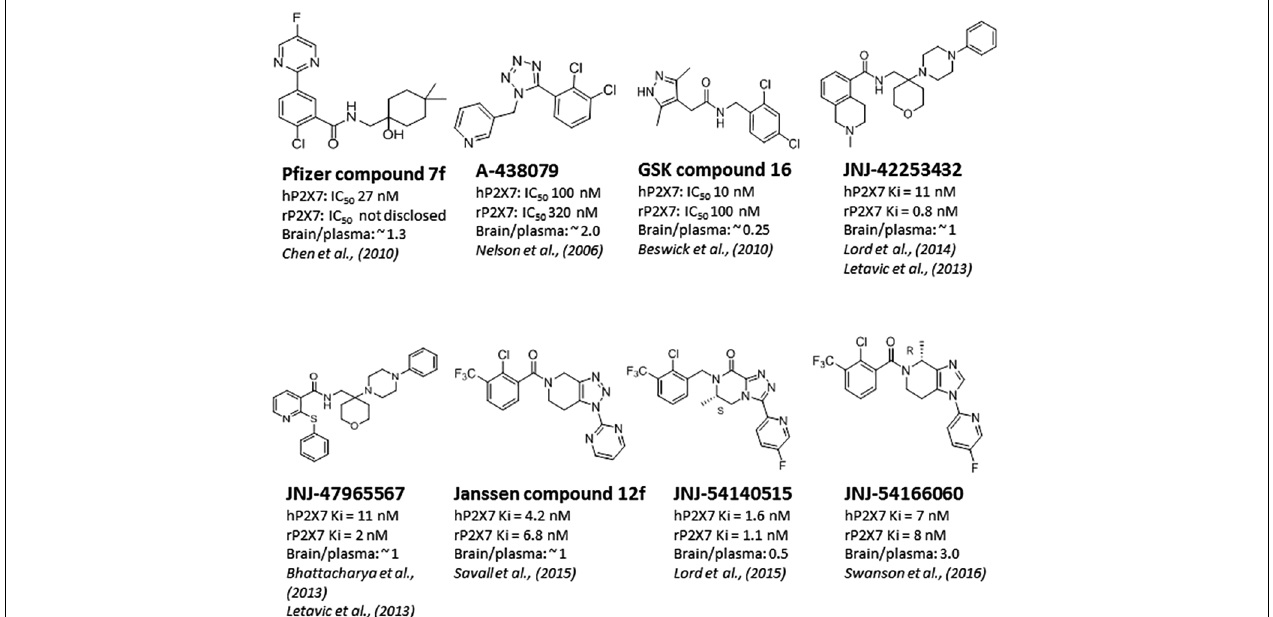
FIGURE 2 | Brain-penetrant P2X7 antagonists.